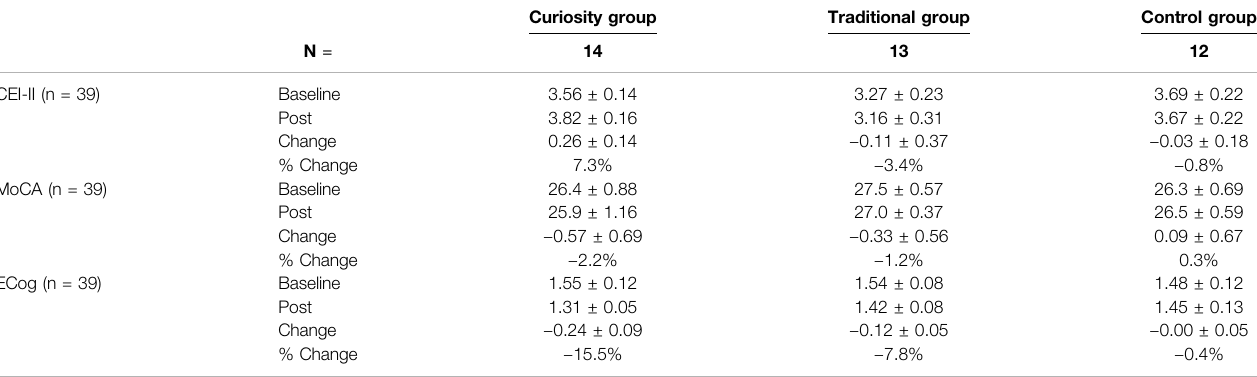
TABLE3| Changesinquestionnairescores(CEI-II,MoCA,ECog)frombaselinetopostinterventioninthethreestudygroups . ValuesforCEI-IIandECogareaveragescores and values for MoCA are total scores. Results are presented as mean ± SEM or percentage (%). Curiosity group Traditional